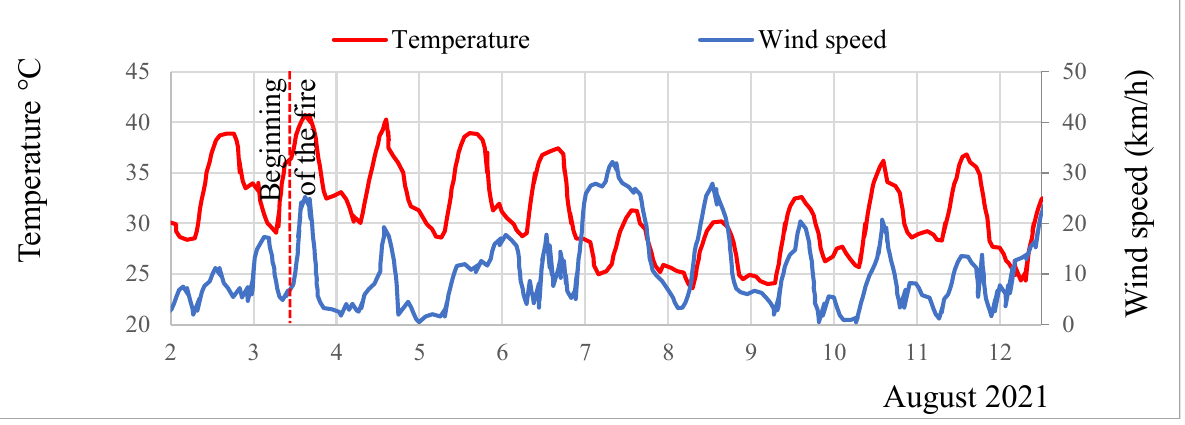
Figure 10. Temperature and wind speed in the area of Euboea [81].